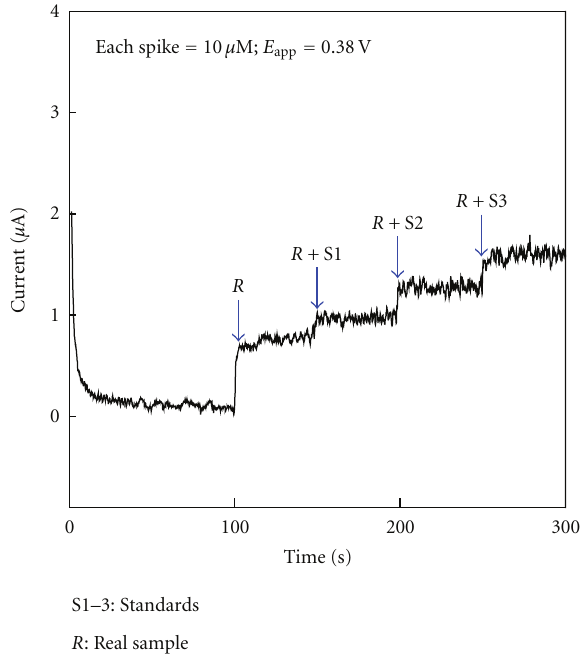
Table 2: Hydrazine content analysis in cigarette smoke real